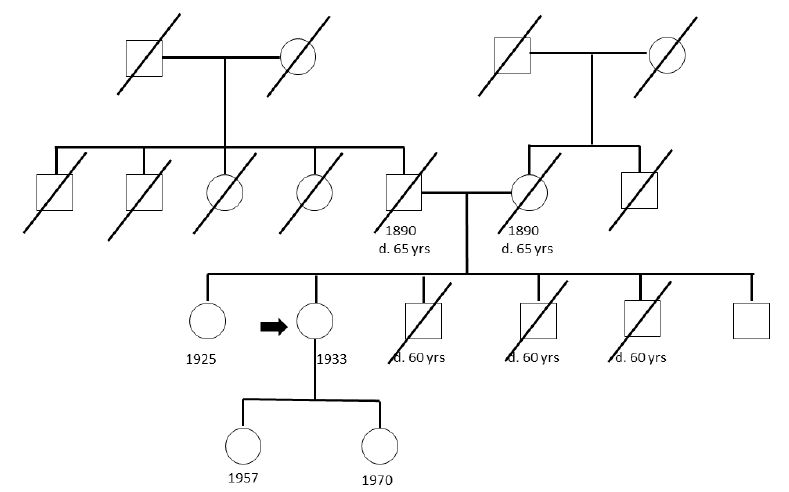
Figure 1. Pedigree of one cancer-free family with the index case indicated by an arrow.